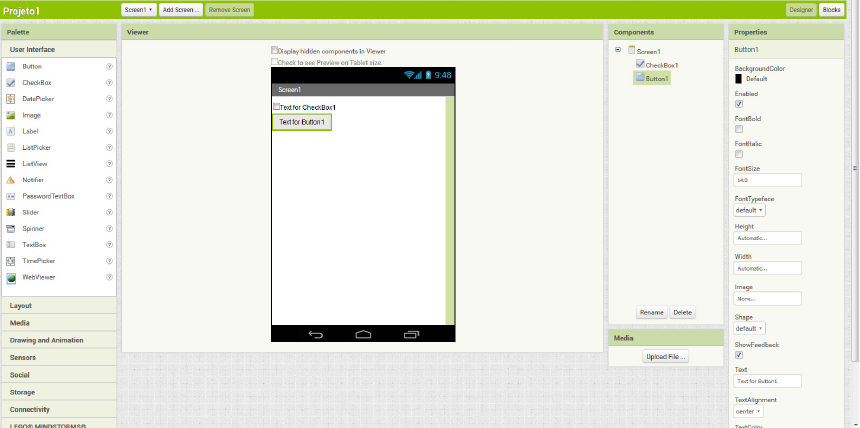
Fig. 1. The main interface of the App Inventor